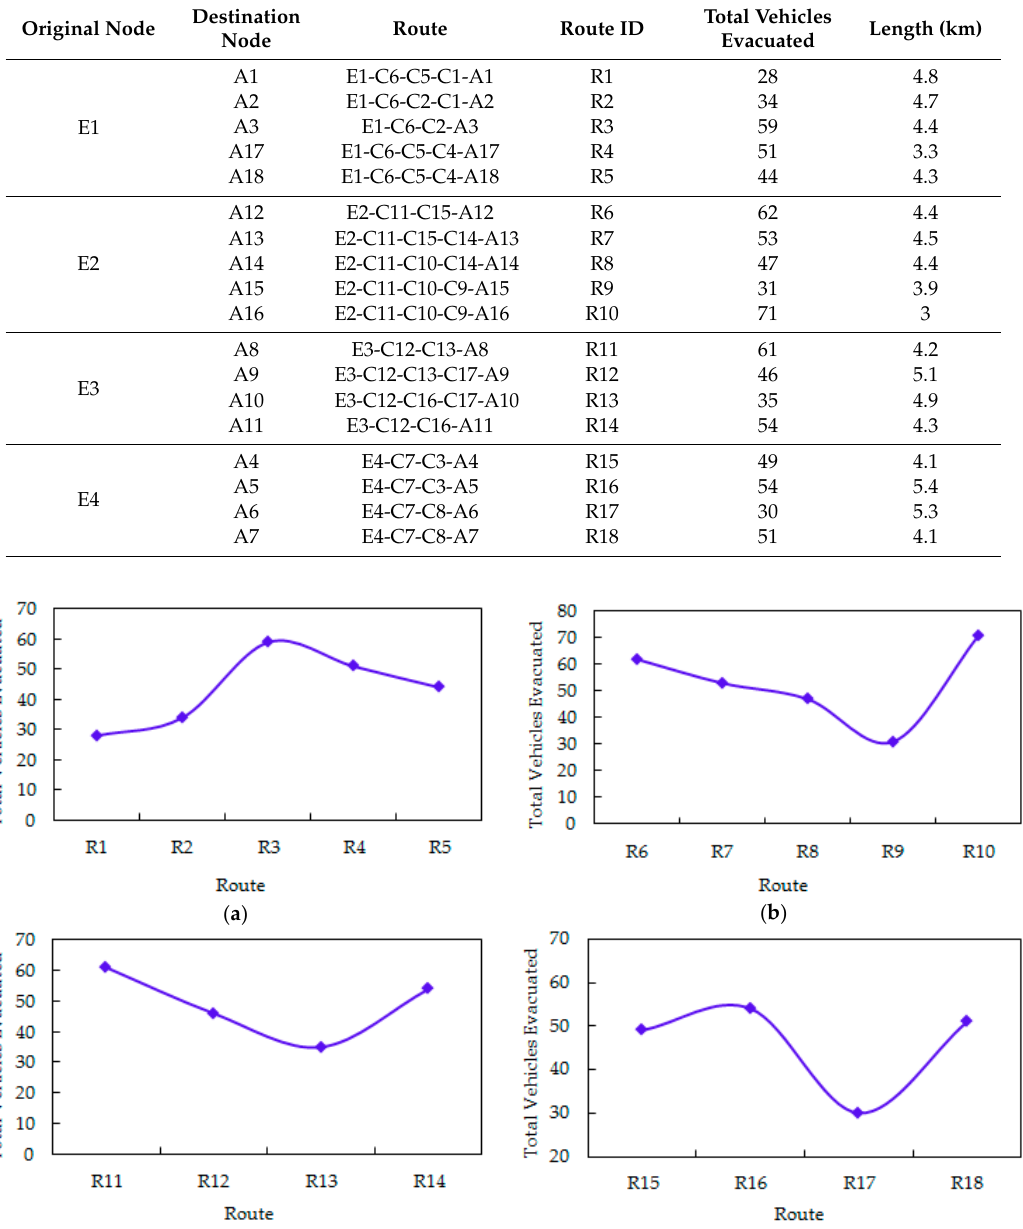
Table 3. Optimal evacuation routes.